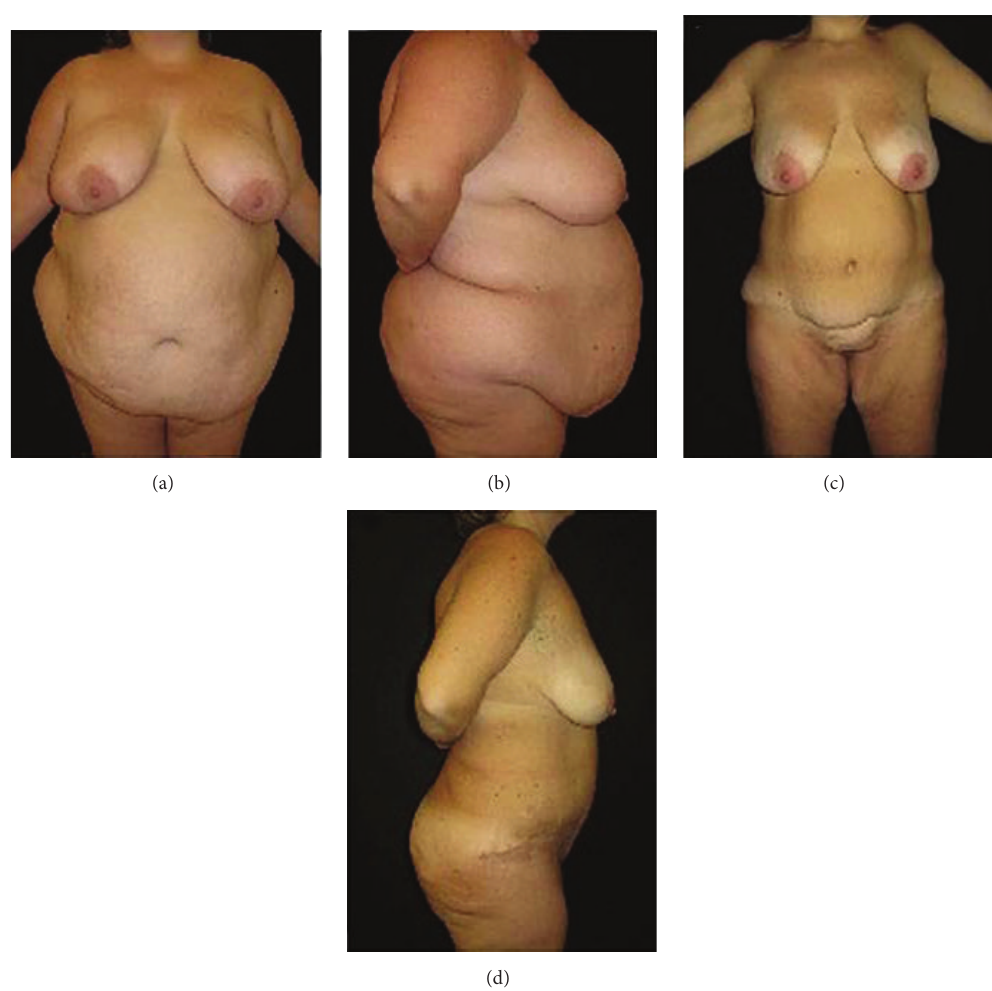
Figure 7: (a) Preoperative frontal view and (b) lateral view of a female patient (BMI = 55 kg/m 2 ; body weight = 147 kg). (c) Postoperative frontal view and (d) lateral view five years after surgery (body weight = 67